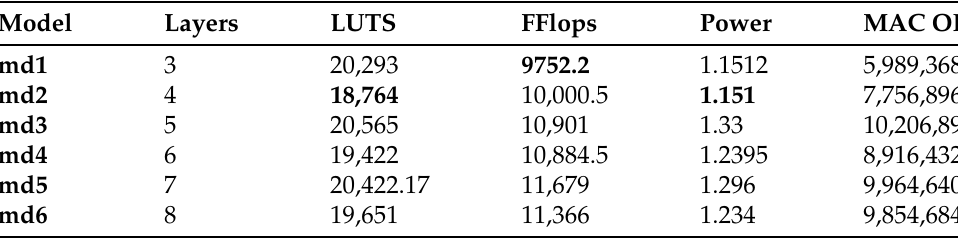
Table 9. Hardware cost estimates for the optimized BNN models.